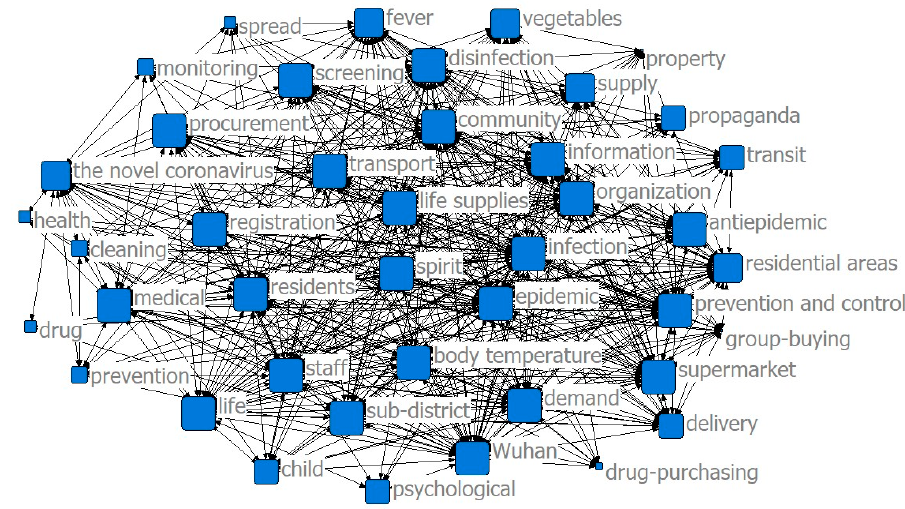
Figure 2. Community services in the threshold period.